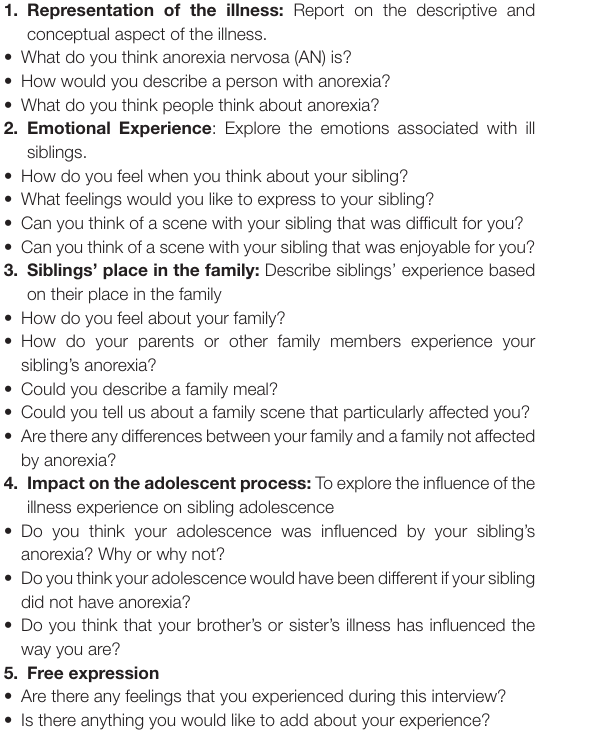
TABLE 1 | Thematic guide for the semi-structured interview during the focus group. 1. Representation of the illness: Report on the descriptive and conceptual aspect of the